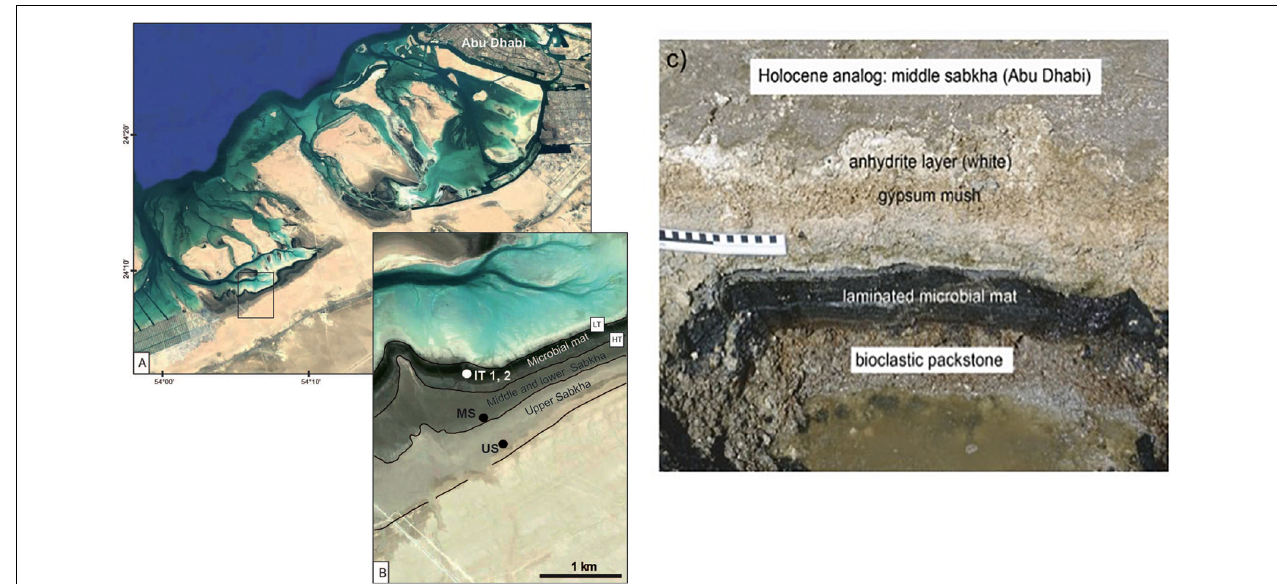
FIGURE 1 | (A) Google Earth Image (2017) of the study area at the Abu Dhabi coastline and (B) details of the sampled locations on the sabkha. Microbial mats develop in the intertidal zone between the low tide (LT) and high tide (HT) level. (C) Illustrated picture of a recent sabkha environment from Abu Dhabi sampled for this project (Sample MS) showing the distinct layers of a modern day sabkha. All the samples in the Holocene were taken from the laminated microbial mat.